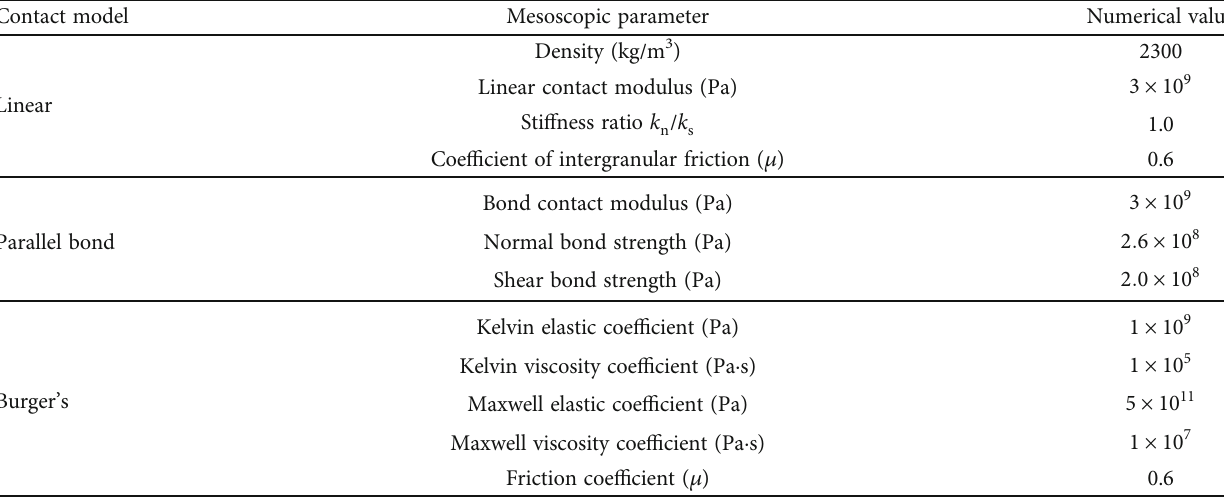
Figure 3: Stress-strain curves of di ff erent con fi ning pressures at 20 ° C: (a) con fi ning pressure 10MPa; (b) con fi ning pressure 20MPa; (c) con fi ning pressure 30 MPa. Table 1: Microstructure parameters of PFC 2D constitutive contact